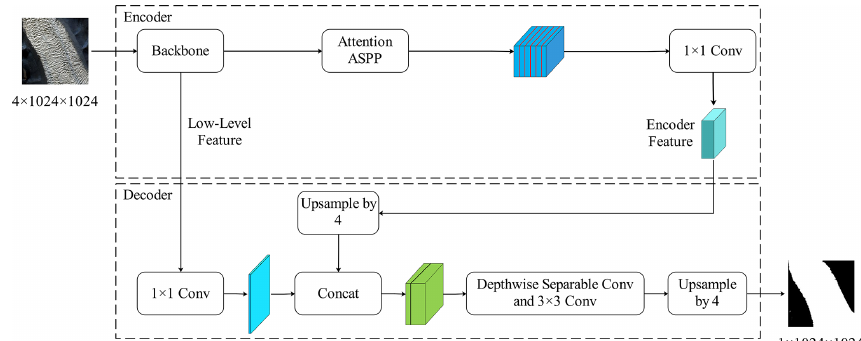
Figure 2. Architecture of Attention DeepLab V3 + .